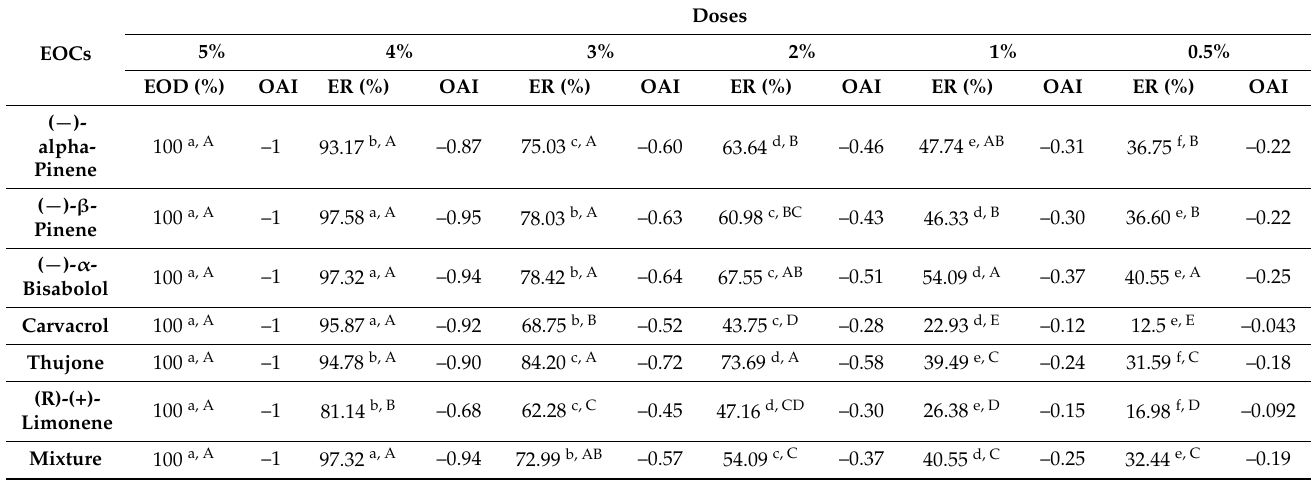
Table 6. The oviposition-deterrent activities of different EOCs against B. dorsalis adults.